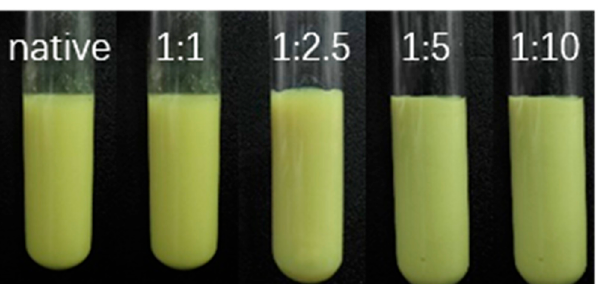
Figure 1. Water dispersions of native quercetin and quercetin particles ( c = 1%) formed by antisolvent precipitation under various solvent/antisolvent ratios.